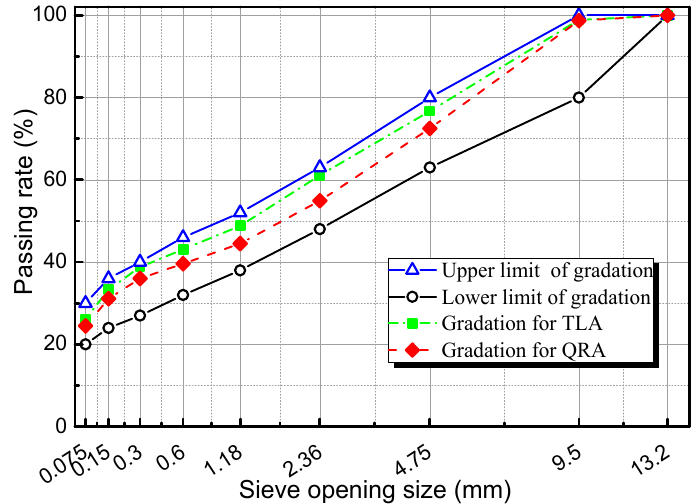
Figure 4. GA-10 gradation curve.